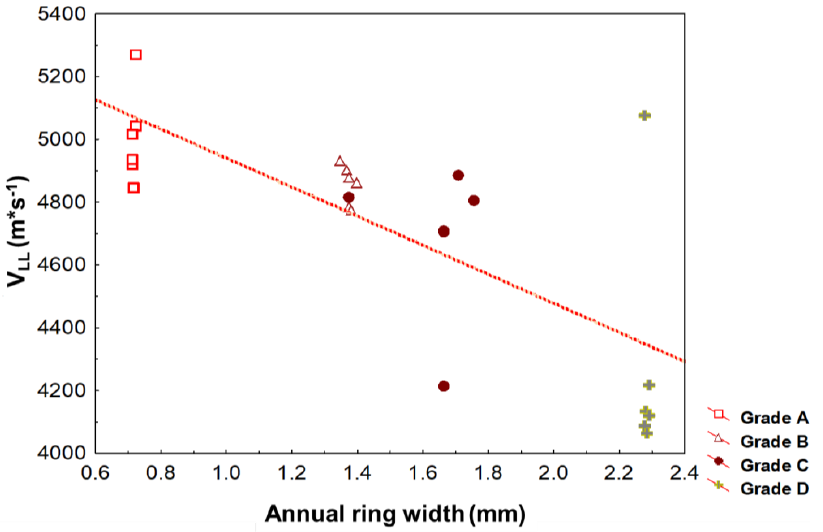
Figure 9. The regression between the sound velocity in the longitudinal direction and the annual ring width.